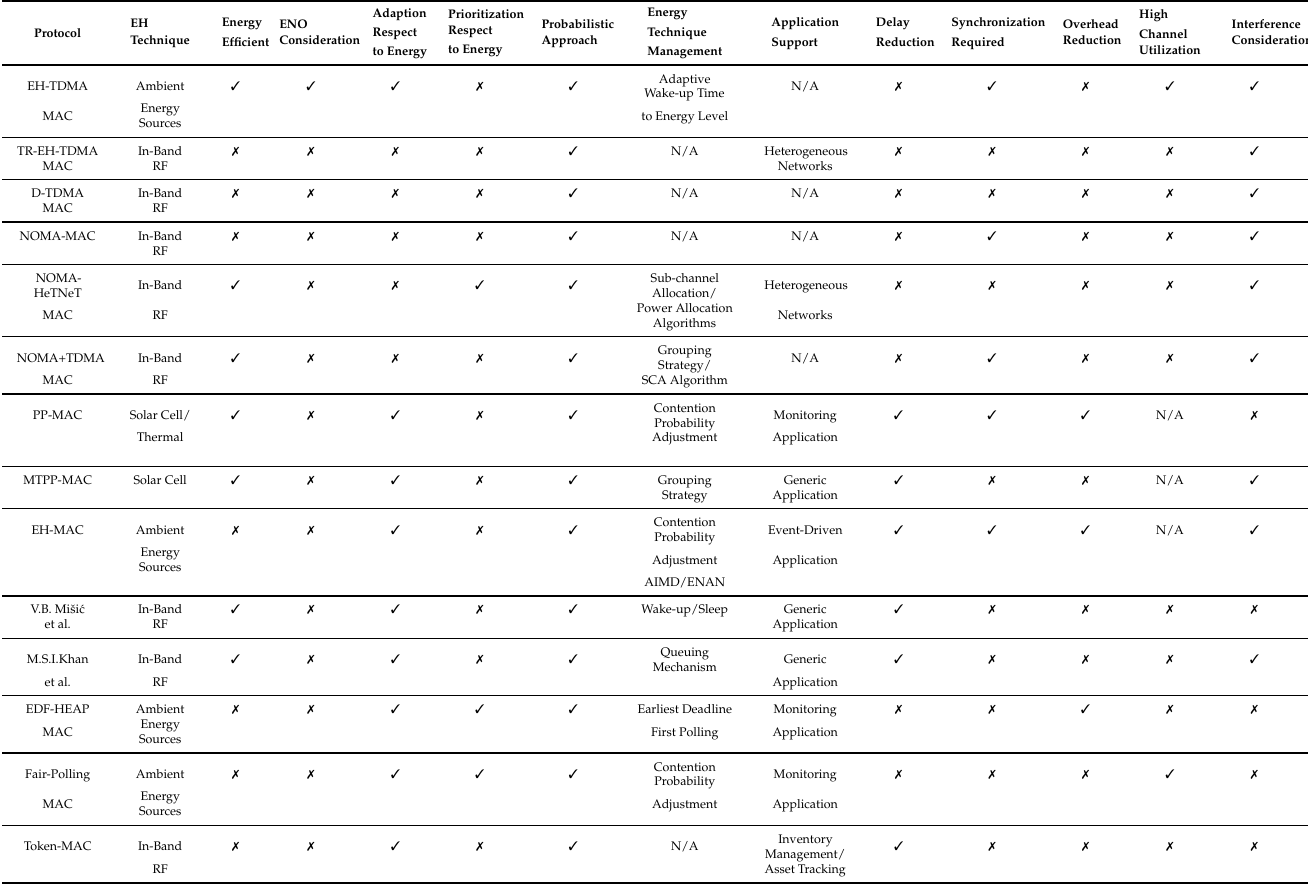
Table 8. Comparison of scheduled access energy harvesting MAC